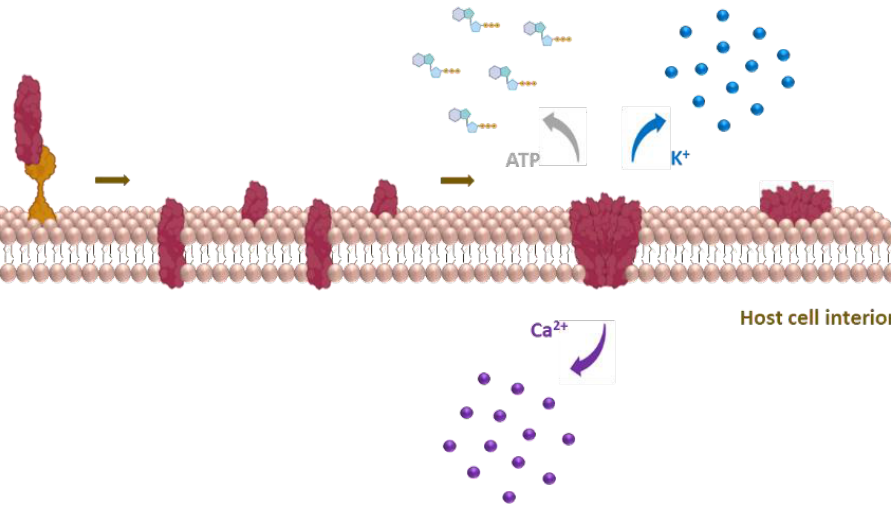
Figure 9. The pore-forming activity of RTX toxins. Although the exact mechanism of oligomerization and pore-forming activity of RTX toxins in vivo is still largely unknown, an approximate mechanism can be given. The RTX toxin interacts with a host receptor and inserts into the membrane in a monomeric form. The monomers interact with each other to form an oligomeric complex. The number of monomers that form an oligomeric structure and the mechanism of formation are still unknown. The oligomeric complex acts as a membrane pore through which calcium ions flow into the cell cytoplasm and potassium ions flow out of the cell. HlyA and LtxA also enable ATP release from host cells directly through the membrane pores formed by the toxins. This image was created using BioRender.com.